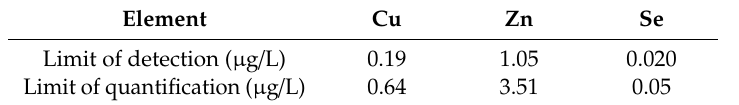
Table A1. Limits of detection (LOD) and quantification (LOQ) for nine elements; all values are in µ g L − 1 .